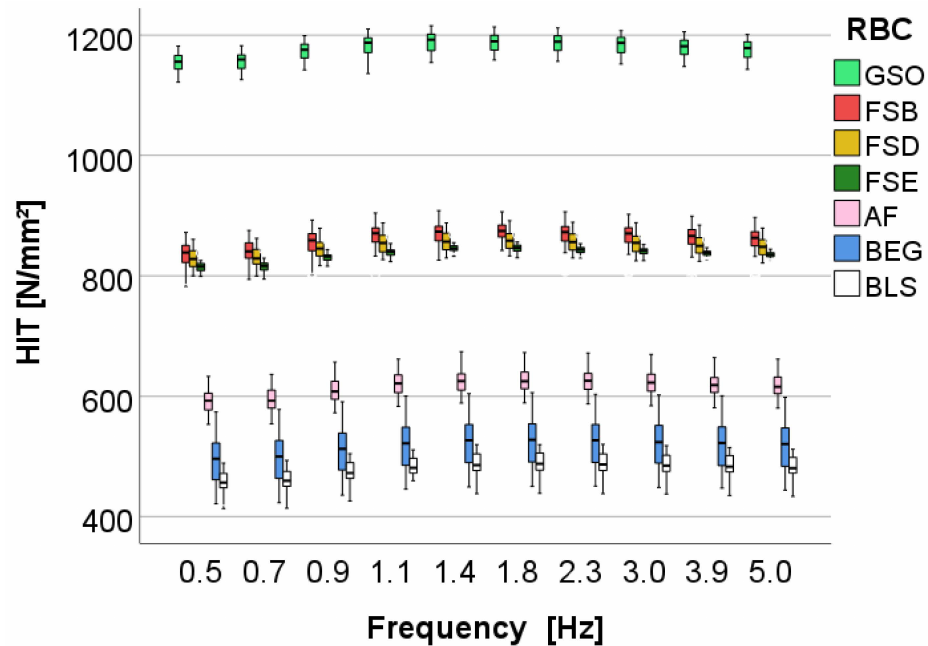
Figure 10. Dynamic mechanical analysis: indentation hardness (H IT ) as a function of material and frequency. Material abbreviation: AF = Admira Fusion; BEG = Brilliant EverGlow; BLS = Beautifil II LS; FSB = Filtek Supreme XTE Body; FSD = Filtek Supreme XTE Dentin; FSE = Filtek Supreme XTE Enamel; GSO = Grandio SO.